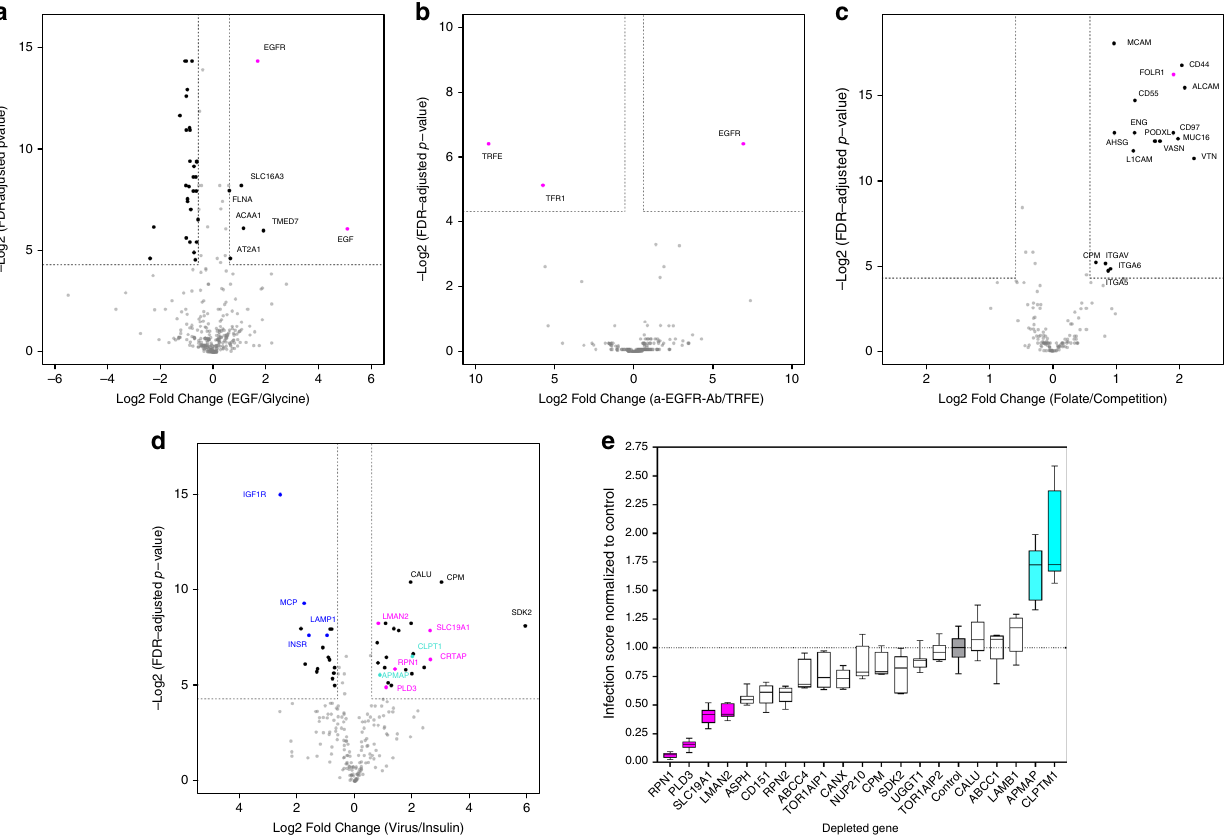
Fig. 2 HATRIC-LRC identi fi es target receptors for ligands ranging from small molecules to intact viruses. All results of HATRIC-LRC experiments are presented in volcano plots, where fold changes of proteins are shown with their respective log-transformed, fold changes are also log transformed false- discovery rate (FDR)-adjusted p values. Target receptors are de fi ned as proteins that have a fold change of greater than 1.5 compared to the control as well as a p value equal to or smaller than 0.05 (Benjamini – Hochberg method), corresponding to a target receptor window in the volcano plot that is framed by dotted lines. All experiments were performed in triplicates per condition, except for the H3N2, where quadruplicates were produced. a HATRIC-LRC with EGF on 20 million H-358 cells. In the negative control, HATRIC was quenched with glycine to map the off-target reaction of HATRIC on the same cell line. The ligand and the known target receptor are highlighted in magenta. b HATRIC-LRC experiments with EGF and TFRE were performed on 1 million MDA- MB-231 cells. In this experiment, two ligands with known receptors served as controls for each other to benchmark the ability to perform HATRIC-LRC with as little as 1 million cells. The ligands and known target receptors are highlighted in magenta. c Folate-based HATRIC-LRC was performed on 20 million folate-starved HeLa Kyoto cells per replicate. In the control, six-fold excess of free folate was used to compete with binding of folate-HATRIC. The target receptor FOLR1 is highlighted in magenta. d IAV-based HATRIC-LRC was performed on 20 million A549 lung adenocarcinoma cells per replicate. In the positive control, insulin was used as ligand, and insulin receptors were correctly identi fi ed. In the IAV-target receptor window, magenta-colored red dots highlight receptors that showed an inhibitory effect on IAV cell entry whereas turquoise dots blue highlight receptors that facilitated IAV cell entry in a siRNA-based knockdown experiment (Fig. 2e). e Effect of siRNA-mediated depletion of candidate receptors on IAV infection of A549 cells. Experiments were conducted in triplicates. Infection scores from siRNA-treated samples were normalized to control samples transfected with non-targeting siRNA (shown in gray). The data are presented as boxplots with whiskers from minimum to maximum values. Boxes extend from the 25th to 75th percentiles. The line in the middle of the boxes depicts the median. The dotted line on the plot shows the median of control group? (normalized to 1). Magenta and turquoise Red and green boxes highlight receptors that showed an inhibitory or facilitative effect on IAV cell entry (Magenta Red: infection score decreased by >50%, turquoise green: infection score increased by >50% upon gene depletion)